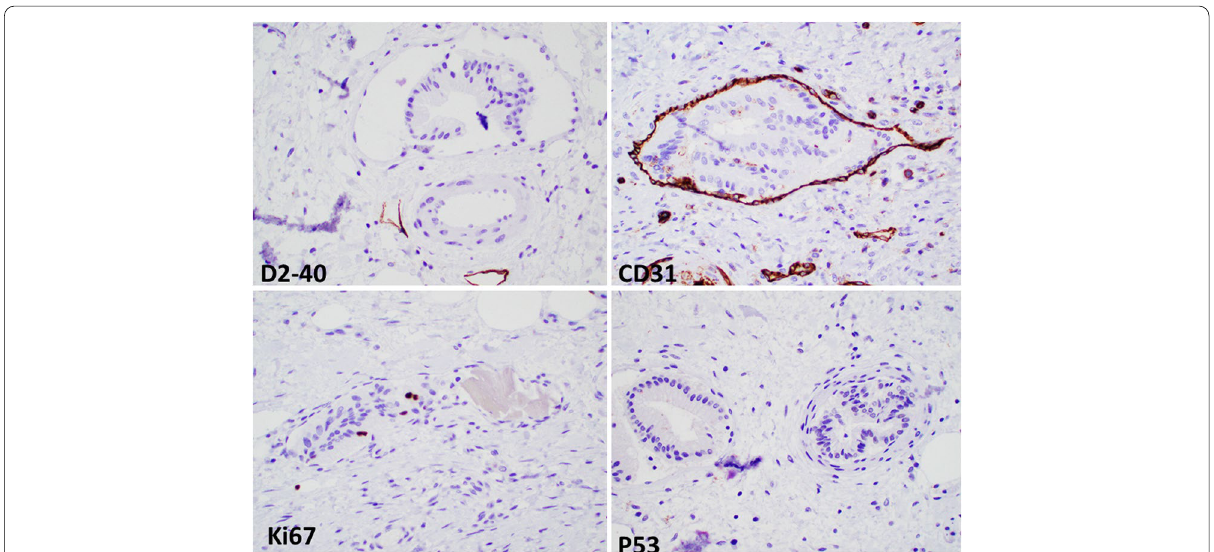
Fig. 2 Ancillary studies. The vessels containing the epithelial groups are negative for D2–40 and positive for CD31 consistent with venules. The intravascular nests show low Ki-67 proliferative activity and are negative for P53, consistent with a benign process. (All images 20X